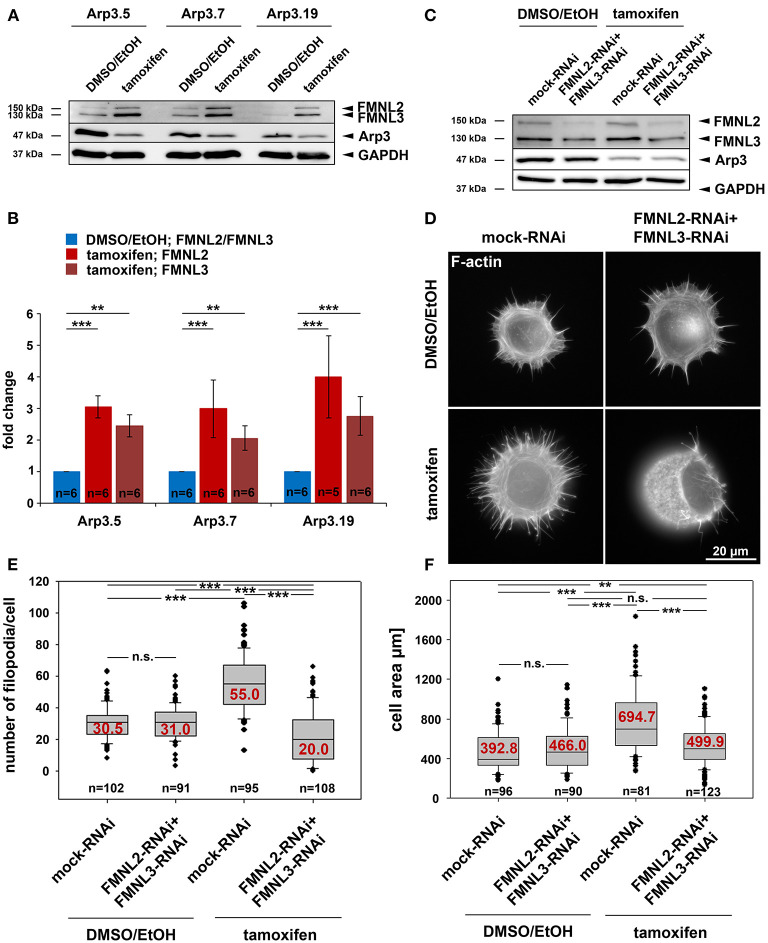
Acute Arp3 removal up-regulates FMNL formin expression enhancing filopodia formation and cell spreading. (A) Representative Western blot of Arp3 as well as FMNL2 and FMNL3 protein levels in Actr3fl/fl clones with and without tamoxifen treatment, as indicated. GAPDH served as loading control. (B) Quantification of FMNL2 and FMNL3 protein levels from Western blots as shown in (A). Bar charts display arithmetic means of FMNL2 and−3 protein levels normalized to GAPDH, with each FMNL variant (shades of red) being presented as fold-change relative to its respective control (blue). Error bars represent SEMs; data obtained from at least five independently generated cell extracts. Statistics were performed utilizing non-parametric Mann-Whitney rank sum test (***p < 0.001; ** < 0.01). Note the significant elevation of FMNL2 and−3 protein levels upon Arp3 suppression in all three clones. (C) Representative Western blot analysis of FMNL2 and FMNL3 protein amounts in detergent-soluble extracts from DMSO/EtOH- and tamoxifen-treated Actr3fl/fl cells (clone Arp3.19) after co-transfection with RNAi plasmids individually downregulating FMNL2 and FMNL3 expression or mock-plasmid as control, as indicated. Note the moderate but consistent reduction of FMNL2 and−3 protein levels with and without tamoxifen-induced Arp3 depletion, as indicated (for quantification results see main text). (D) Representative phalloidin stainings of Actr3fl/fl cells (clone Arp3.19) control or tamoxifen-treated, and combined with mock- or FMNL2/3-RNAi after 15 min of spreading on fibronectin-coated coverslips. (E,F) Quantification of filopodia formation (E) and spreading area (F) of cells as presented in (D); box and whiskers plots as described for Figure 4B. n = total number of cells analyzed from three independent experiments. Statistics were performed utilizing non-parametric, Mann-Whitney rank sum test (***p < 0.001; ** < 0.01; n.s. not significant). Note that Arp3 knockout is accompanied by a pronounced increase in filopodia numbers that are reduced even below Arp3-treatment control levels upon FMNL2/3 RNAi. In addition, the increase in tamoxifen-induced cell area upon 15 min of spreading is also suppressed significantly by FMNL2/3 knockdown.